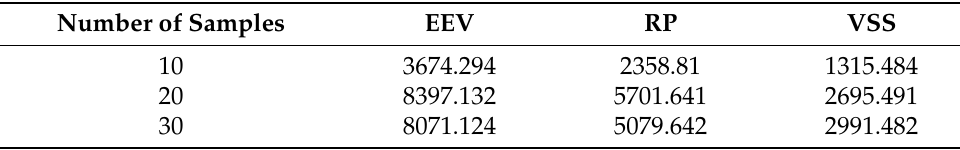
Table 5. Value of stochastic solutions ($